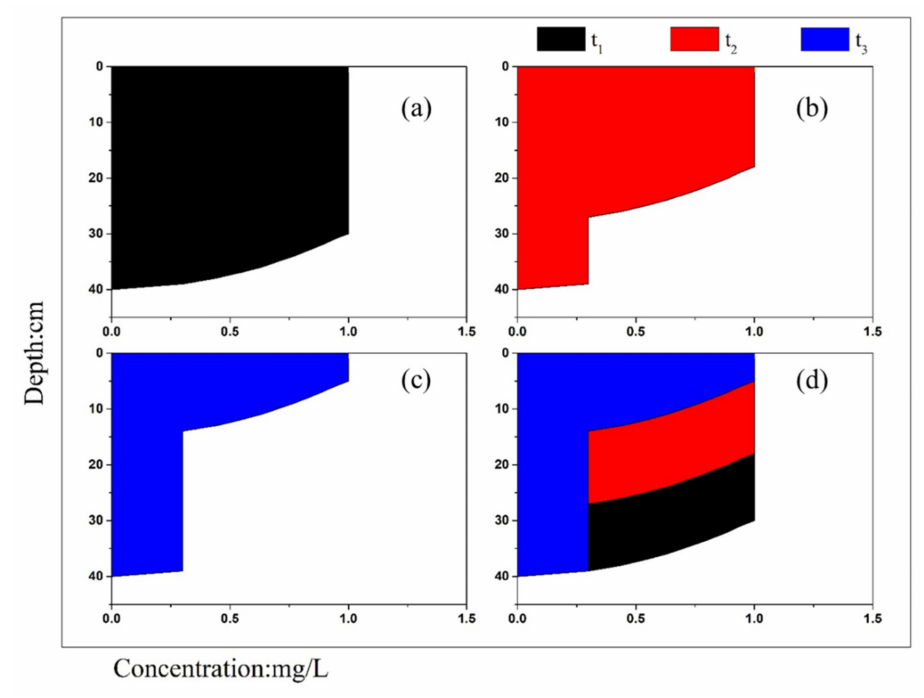
Figure 2. Illustration of the integral of concentration curve versus depth at: ( a ) first observation time t 1 ; ( b ) second observation time t 2 ; ( c ) third observation time t 3 ; ( d ) is the overlap of previous